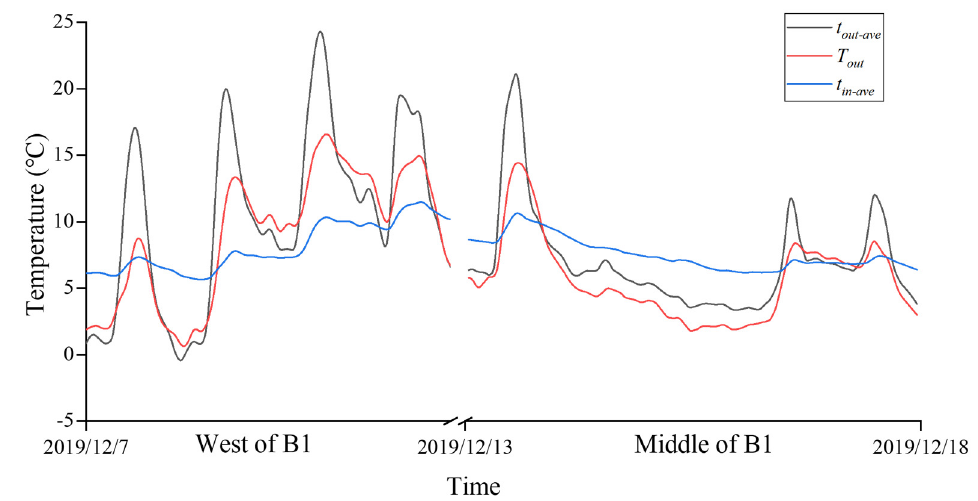
Figure 6. Indoor and near-wall temperature changes of B1.